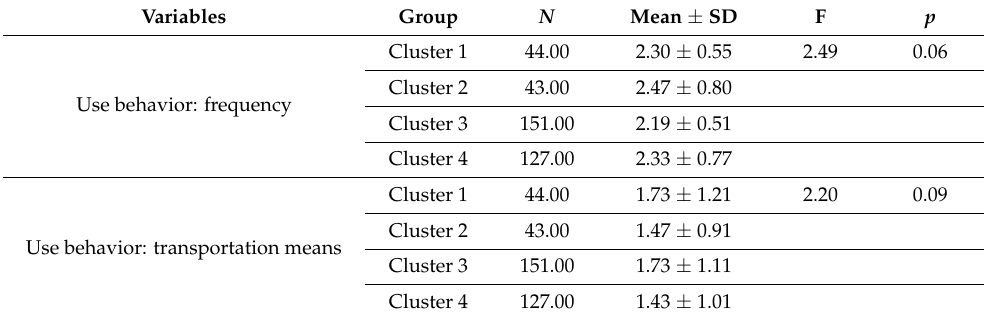
Table 6. Analysis of the differences in green space use behaviors among different